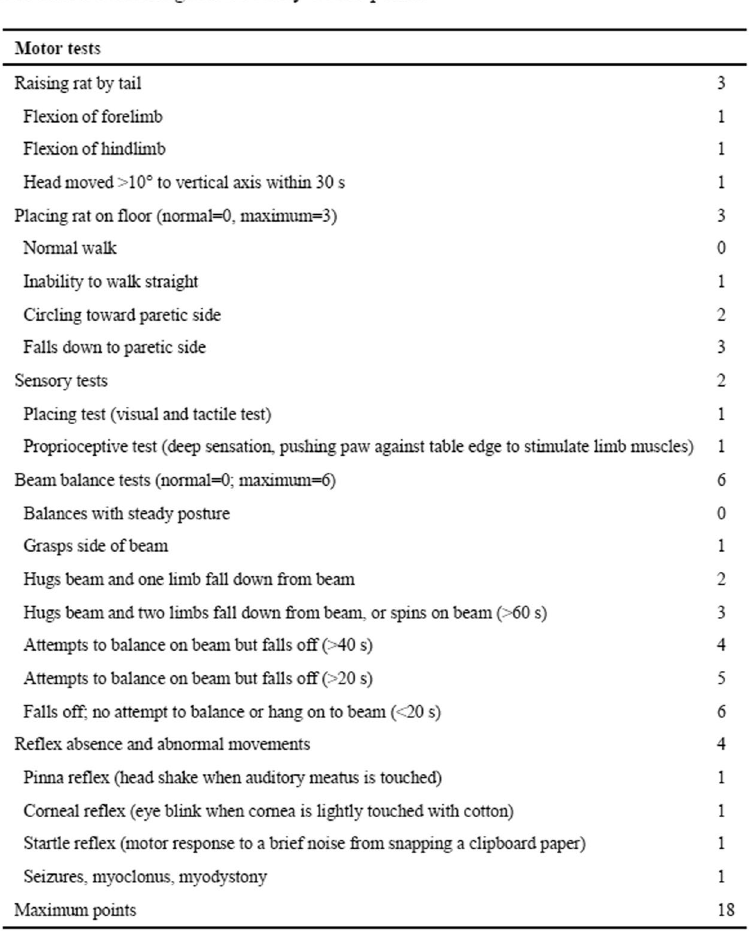
Figure 9. Modified Neurological Severity Score points.